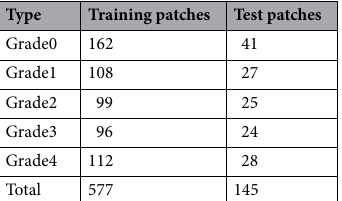
Table 2. Proposed dataset grades